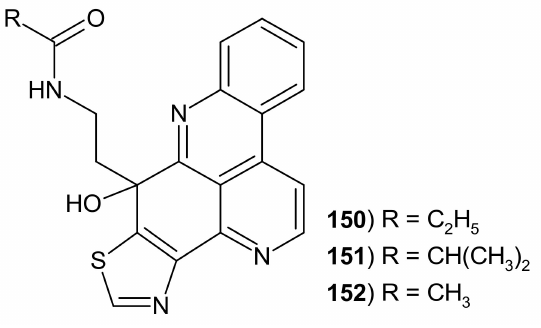
Figure 39. Sagitols